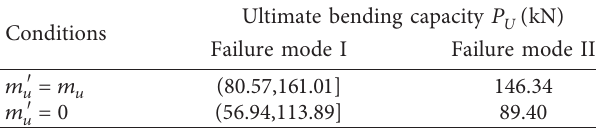
Table 3: Extreme values of the flexural